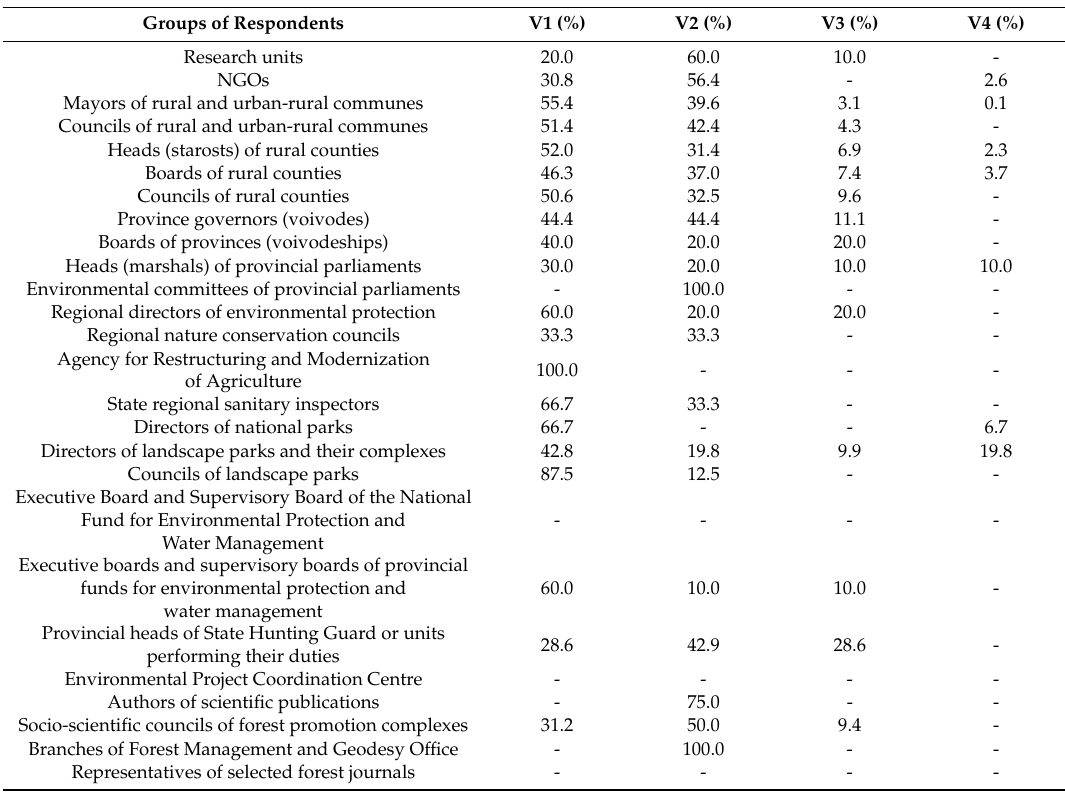
Table 4. The four most frequently chosen variants to answer Question 3 (who should finance nature conservation tasks in the State